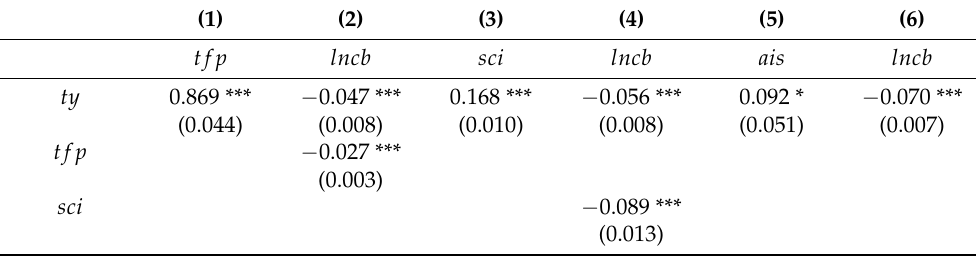
Table 8. Transmission